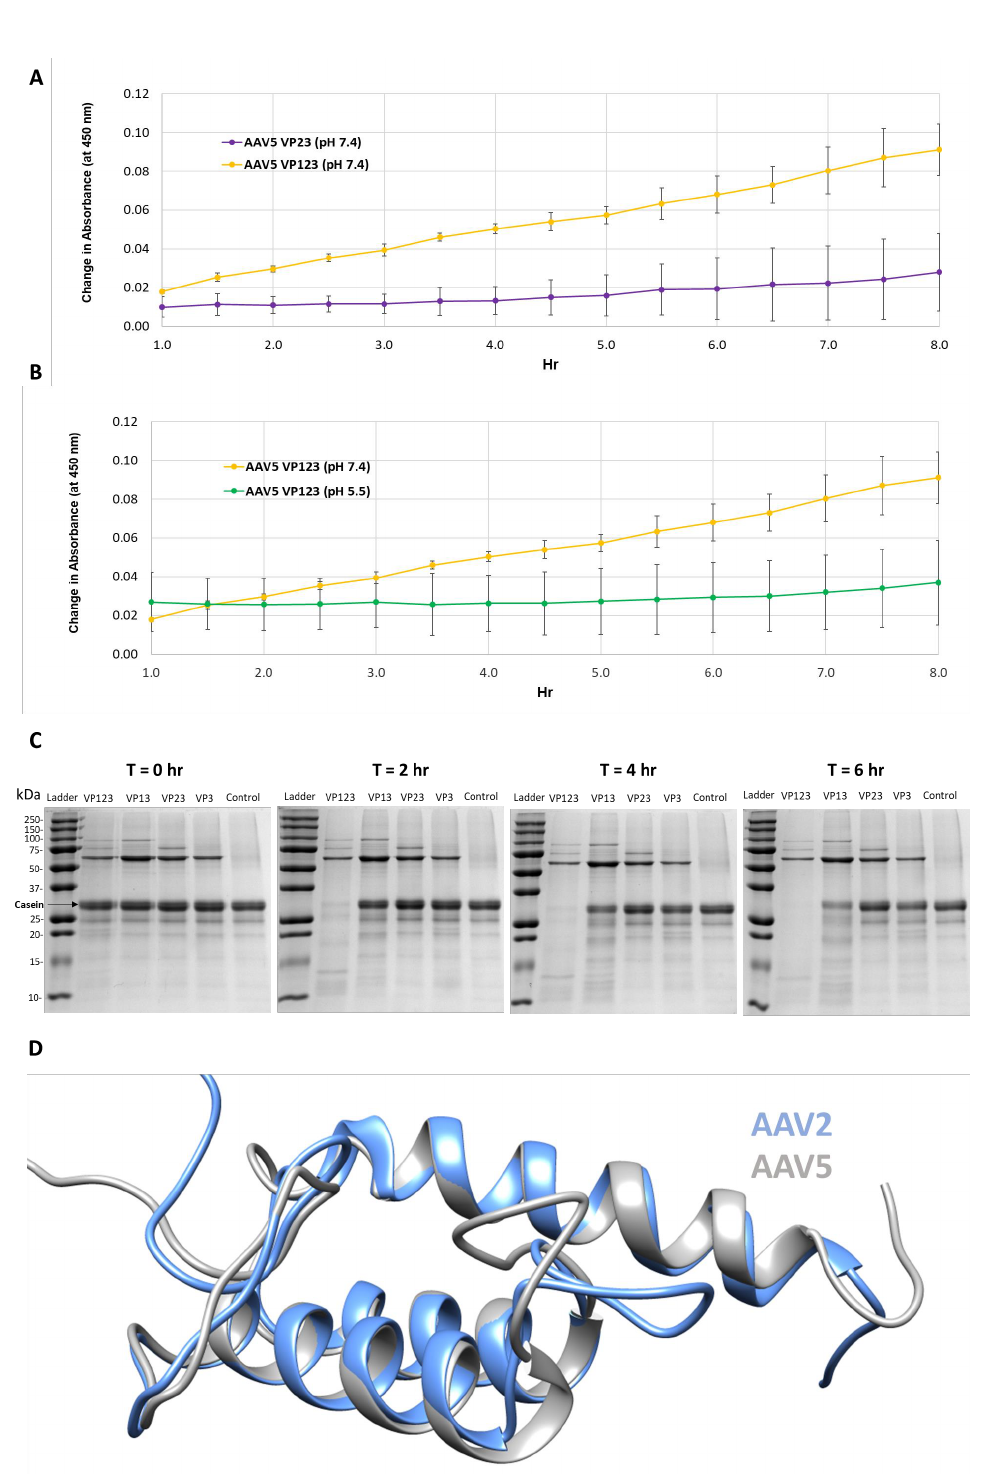
Figure 1. Protease activity is VP1 and neutral pH dependent. ( A ) Colorimetric readout ( y -axis) over time (hr, x -axis) for a casein substrate degradation by AAV5 capsids assembled from VP1, VP2 and VP3 or only VP2 and VP3. ( B ) Same as in ( A ) but for AAV5 VP1, VP2 and VP3 capsids at pH 7.4 and 5.5. ( C ) SDS-PAGE of AAV2 VLPs, containing the VPs shown, incubated with a casein substrate at 37 ◦ C for 2, 4 and 6 h. Observations confirm the need to have VP1 and physiological pH for activity. ( D ) Superposition of AAV2 (blue) and AAV5 (gray) VP1u models. N -terminal domains of models with predicted disorder not